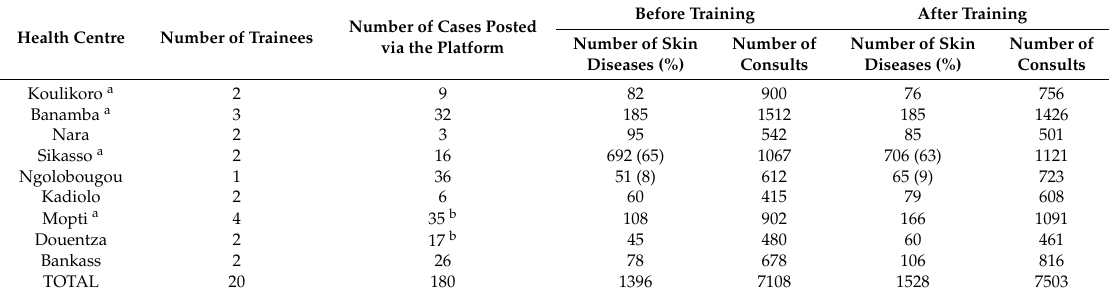
Table 1. Evaluation of health centres: proportion of skin diseases before and after training and distribution of trainees and cases posted via the platform.